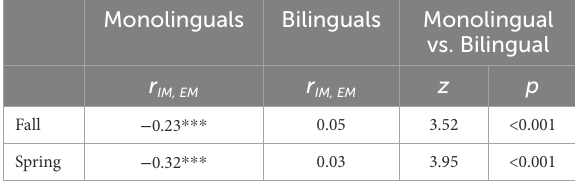
TABLE 2 Correlations between intrinsic and extrinsic motivation for monolingual and bilingual students. Monolinguals Bilinguals Monolingual vs.